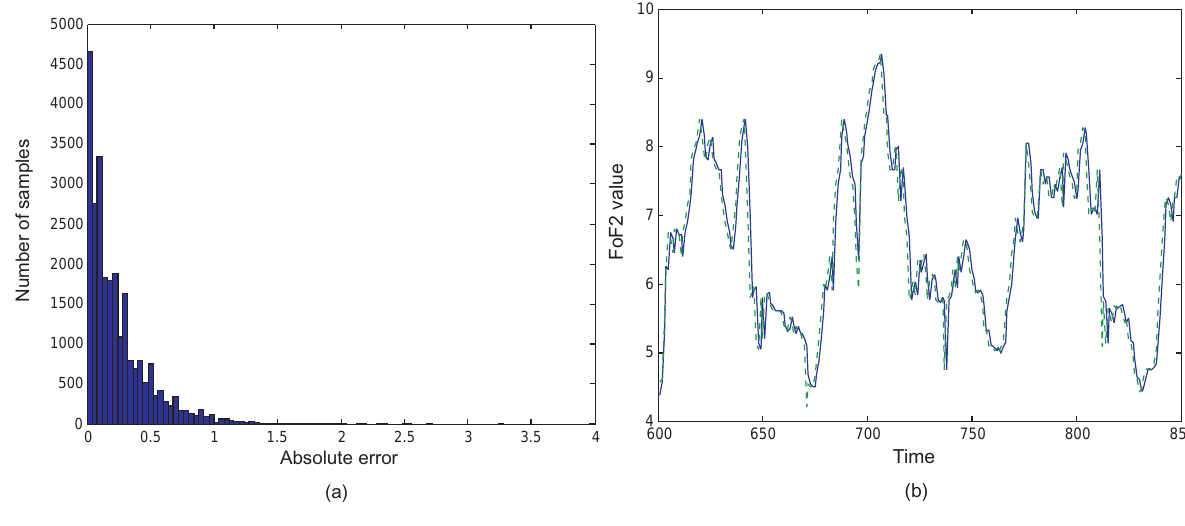
Fig. 4. One-step ahead (15min) prediction, with the persistence predictor. (a) The histogram of the absolute differences of the computed and the actual outputs, for the test set. (b) The actual (solid line) and the computed (dotted line) outputs for a short time interval of the test set.